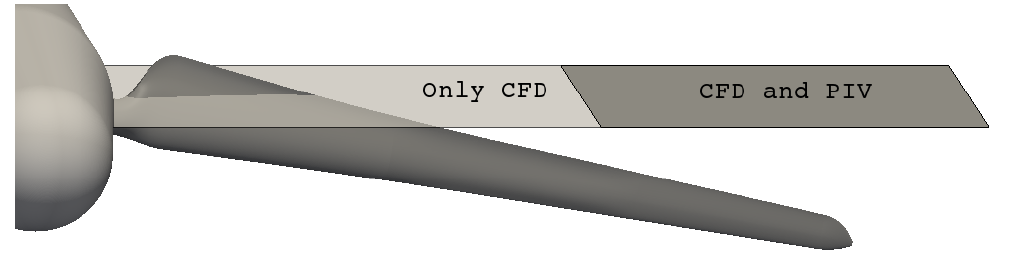
Figure 6. Schematic view of the plane where the flow field was measured 10 (cid:14) after the blade passage. The PIV windows only cover the outboard region, whereas the CFD results encompass the whole blade span.